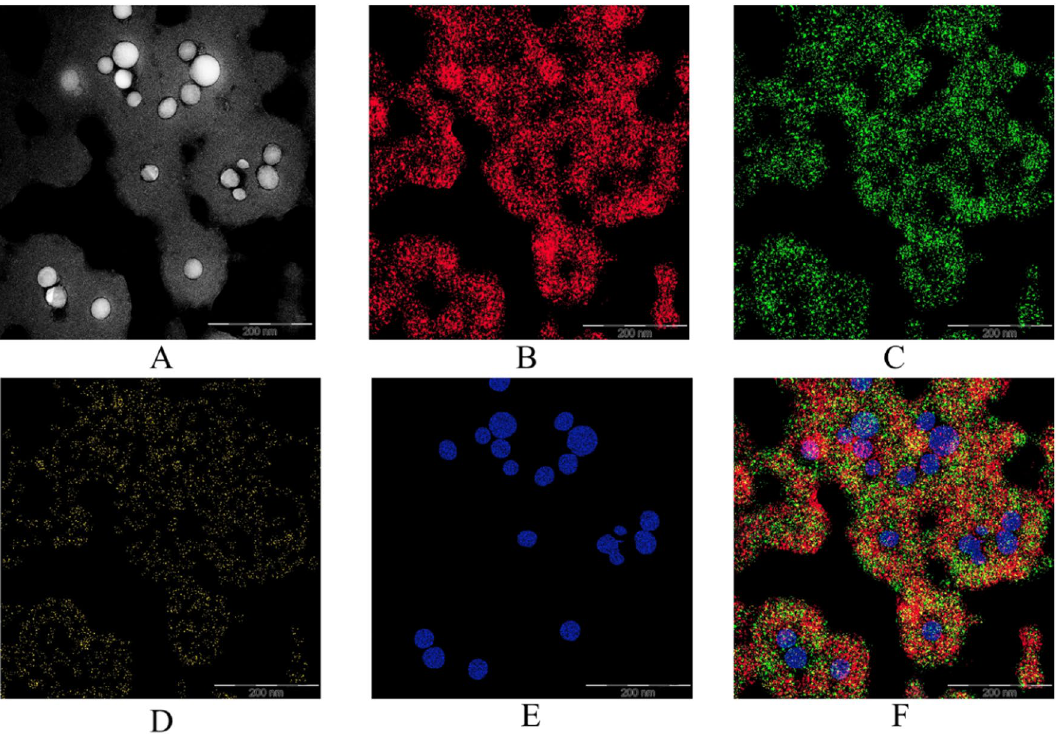
Figure 8. HAADF-TEM image and EDS maps of positive Se NPs sol at magnification × 320000: ( A ) HAADF- TEM image, ( B ) EDS maps of C, ( C) EDS maps of N, ( D ) EDS maps of O, ( E ) EDS maps of Se, ( F ) EDS maps of all